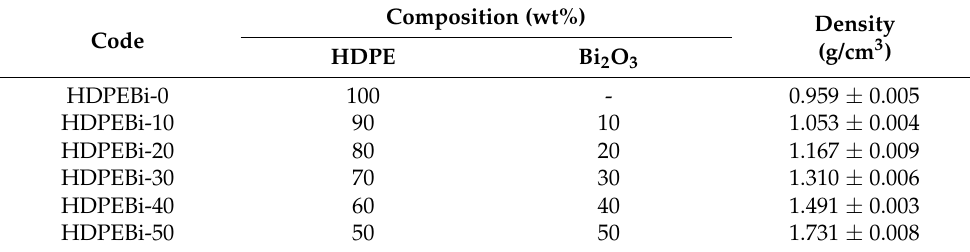
Table 1. Codes, chemical compositions, and densities of HDPE-Bi 2 O 3